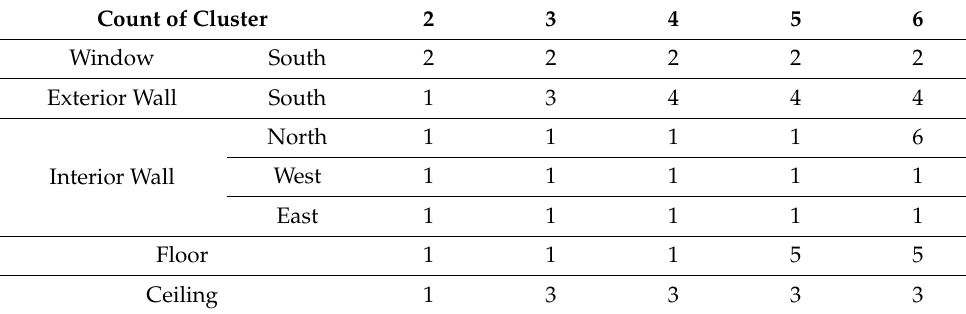
Table 2. Clustering results for interior surfaces.